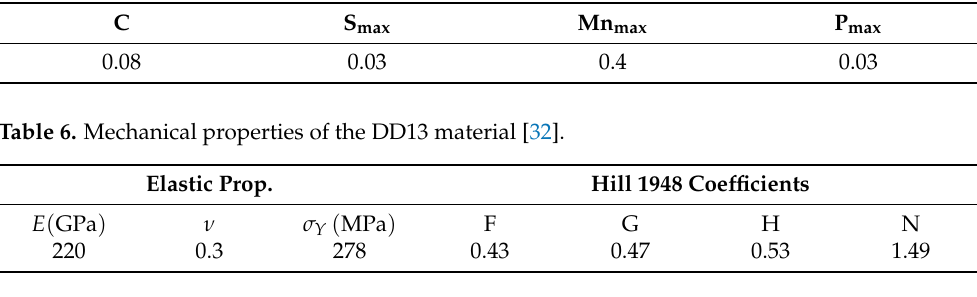
Table 7. Hardening and damage parameters for DD13 [32].